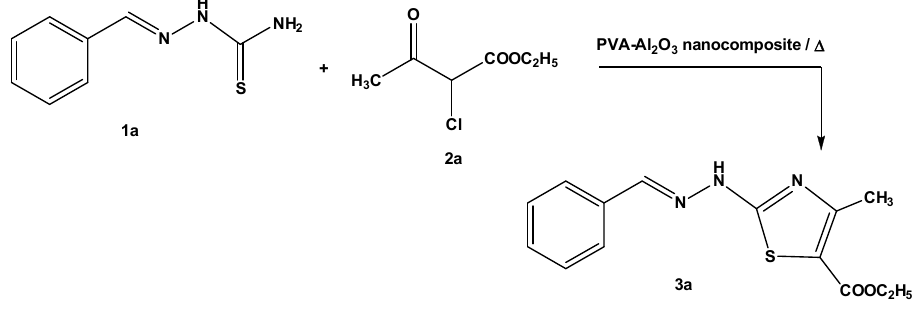
Figure 5. XRD pattern of virgin PVA and PVA-Al 2 O 3 nanocomposite.